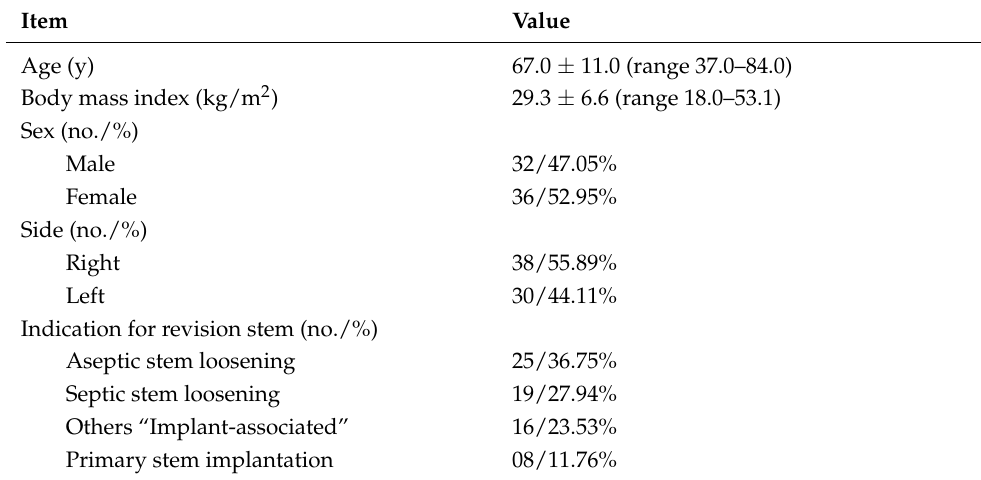
Table 1. Patient demographics.